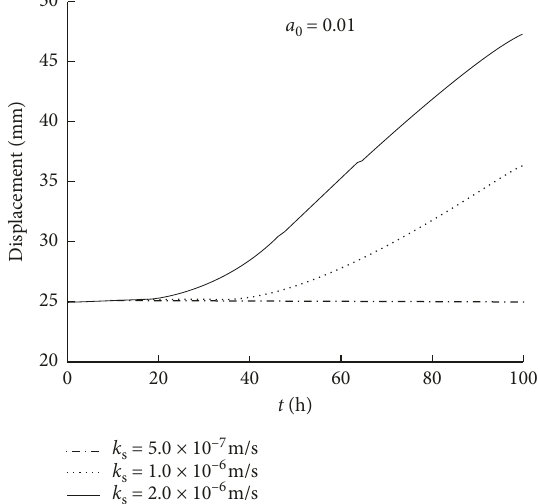
Figure 7: Effect of rainfall intensity on horizontal displacement of pile top.